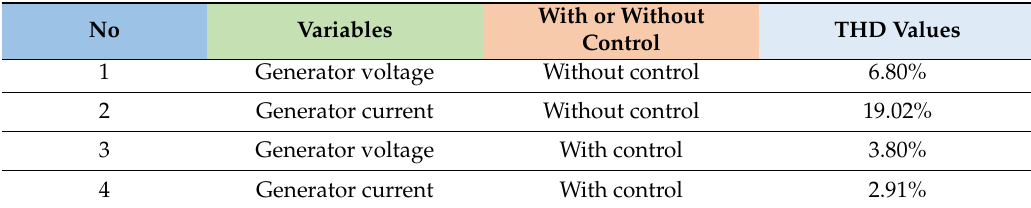
Table 2. Results Comparison.